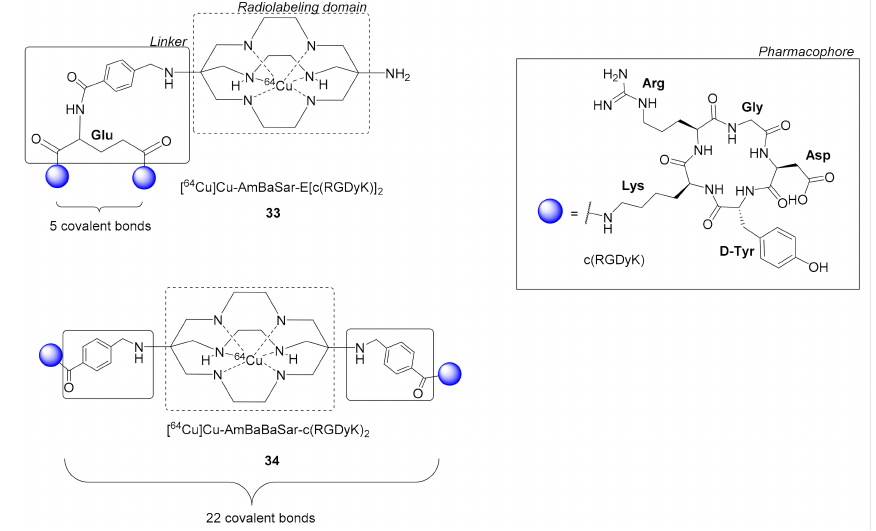
Figure 10. Dimeric c(RGDyK) 2 radioligands [ 64 Cu]Cu-AmBaSar-E[c(RGDyK)] 2 32 and [ 64 Cu]Cu- AmBaBaSar-c(RGDyK) 2 33 bearing the hexaazamacrobicyclic sarcophagine (Sar) chelator, AmBa = 4-(Aminomethyl)benzoic